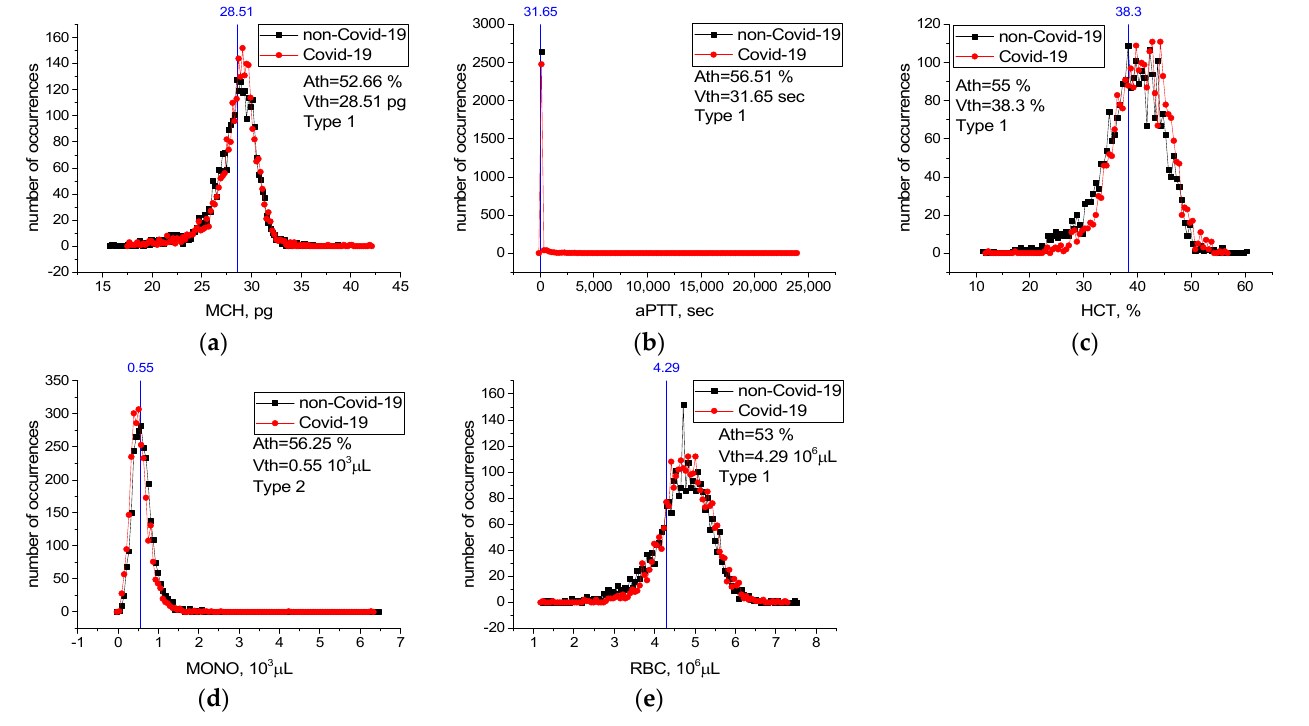
Figure 7. Case distribution histograms for MCH ( a ), aPTT ( b ), HCT ( c ), MONO ( d ), RBC ( e ) from sick and healthy individuals and the threshold values Vth of these features in the diagnosis of the disease. Histogram bin sizes are listed in Table A1.